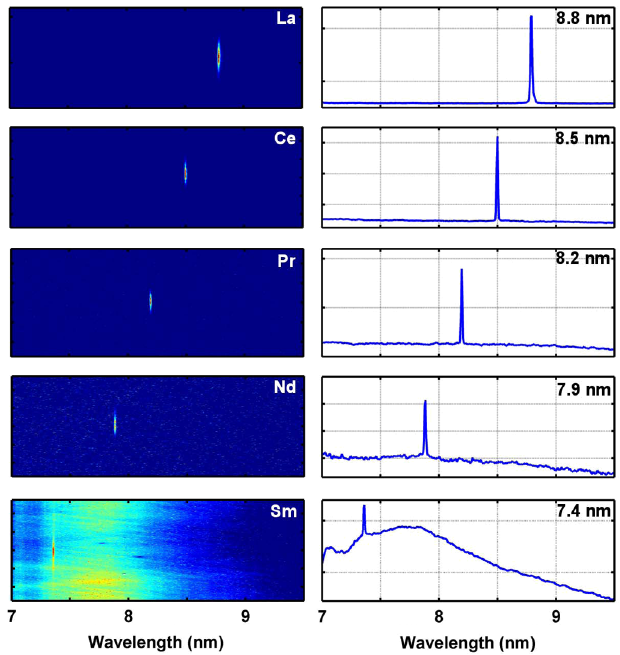
FIG. 6. End-on spectra showing lasing at progressively shorter wavelengths in the 4 d 1 S 0 ! 4 p 1 P 1 line of nickel-like lantha- nide ions, down to (cid:1) ¼ 7 : 36 nm in nickel-like